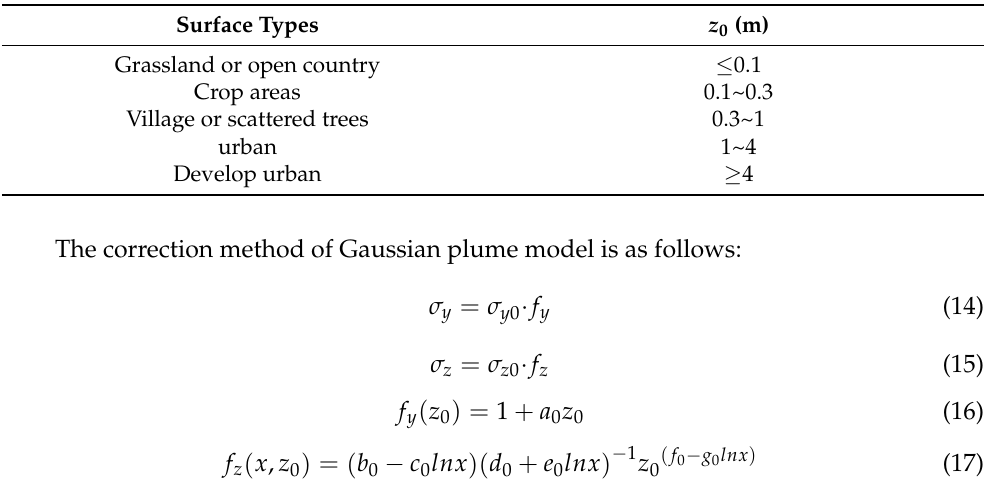
Table 4. Range of ground roughness values for different surface